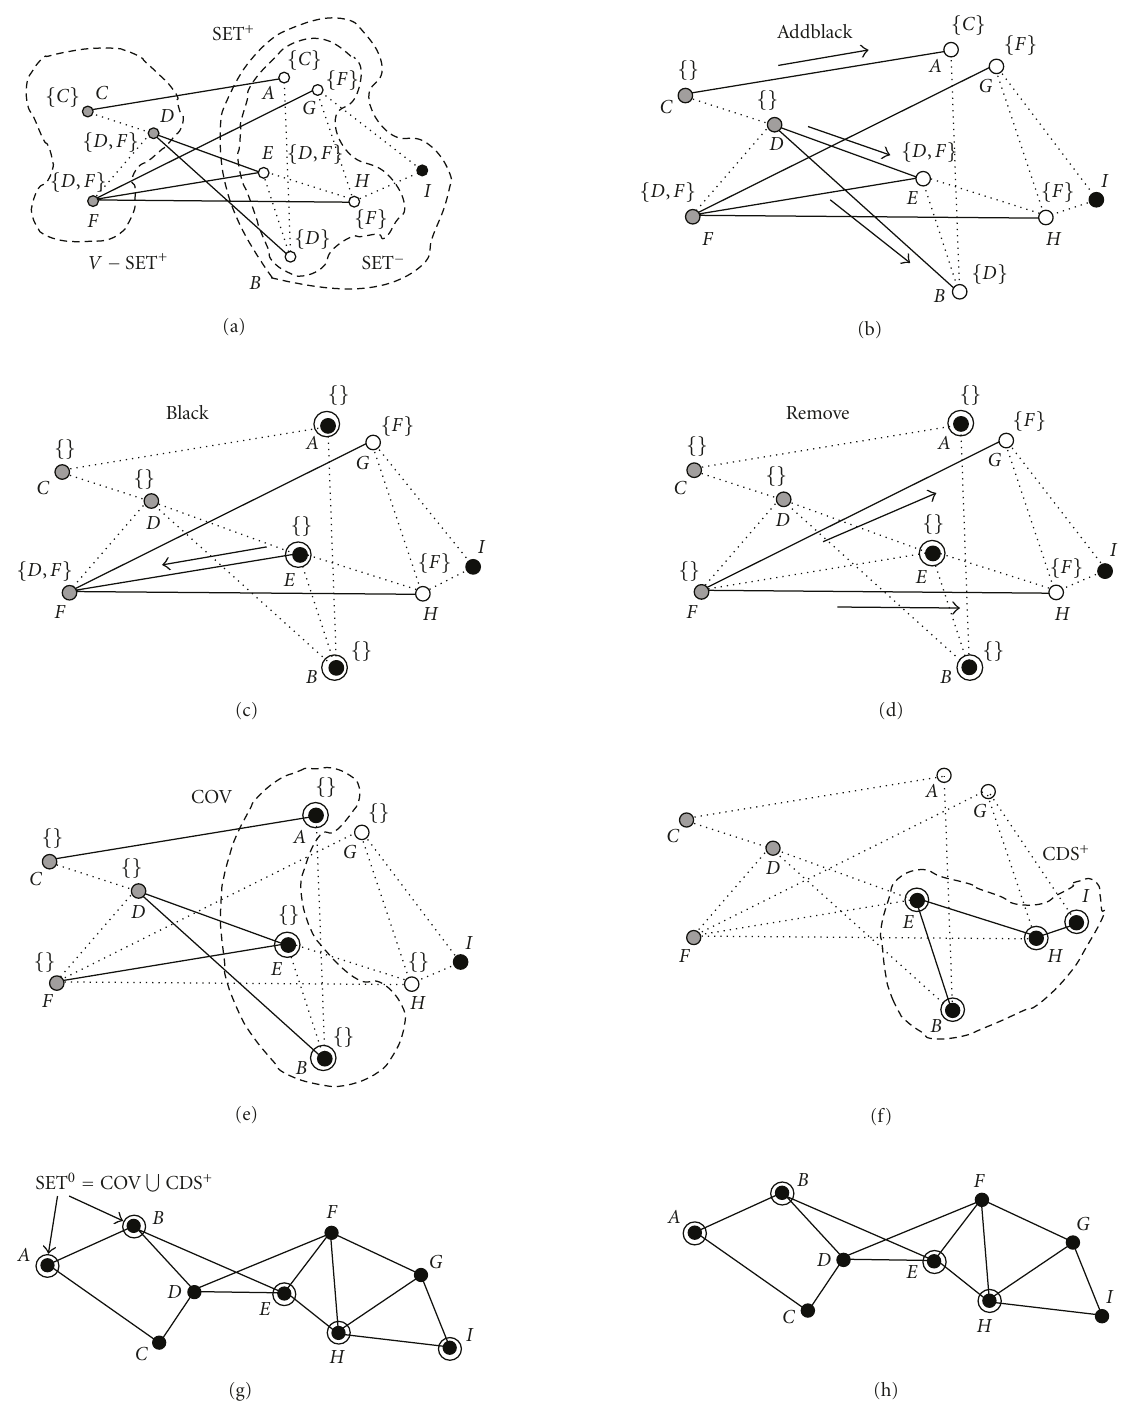
Figure 9: Finding a BACDS in the network in Figure 6(a). (a) SET + and SET − in G , set list( i ) or list gray ( i ) of each node i are listed above. (b)–(e) Finding COV in SET − . (f) Finding CDS + in SET + . (g) SET 0 is the resulting BACDS. (h) The optimal BACDS of this network.